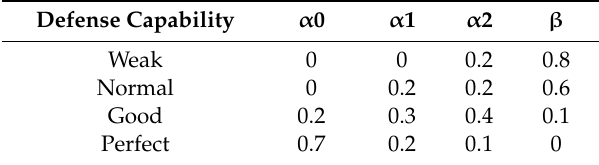
Table 1. Defense parameters of different systems.